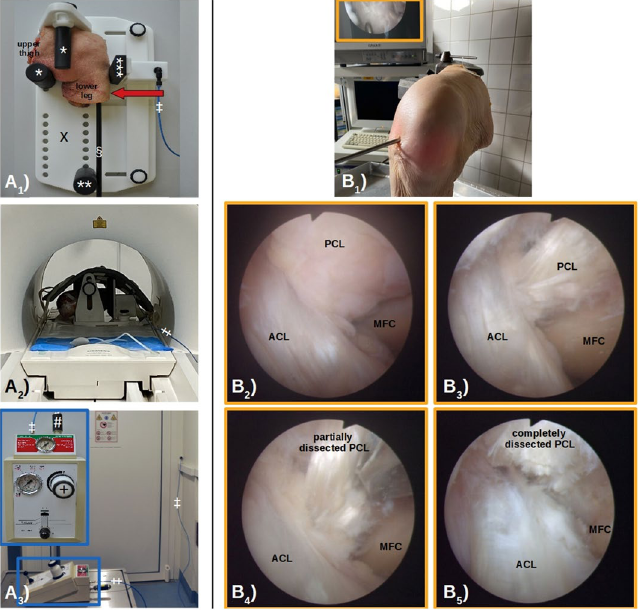
Figure 3. The MRI Posterior Drawer Test —Details of the MRI ( A ) and Arthroscopic Setup ( B ). ( A 1 ) Loading unit: The knee joint specimen was positioned on the base plate (X) in the lateral position at 90° of flexion and fixed with two counter-bearings at the distal upper thigh (*) and one counter-bearing at the distal lower thigh (**). Posterior loading of the tibia relative to the fixed femur (red block arrow) was induced via the padded pressure applicator (***) placed on the level of the tibial tuberosity. To compensate for the lacking distal lower thigh, a polyvinyl-chloride rod was inserted into the medullary cavity (§) to extend the tibia. The loading unit was connected to the control unit by standard pressure lines (‡). ( A 2 ) Fully operational setup: The specimen- loaded device was positioned centrally in the clinical MRI scanner’s bore and covered with an 18-channel body coil used for imaging. A pressure line connected the loading and control units (‡). ( A 3 ) Control unit: Outside of the scanner room, the control unit was connected to the loading device (‡). Once pressurized by carbon dioxide cartridges (#), pressure level (and resultant force on the joint) were controlled by a manometer ( +). Left upper box (framed in blue) indicates close-up view of the control unit. ( B 1 ) Arthroscopy setting: Following injection of fluid, the knee joint was accessed via the anterolateral portal. Arthroscopy tower in the background. ( B 2–5 ) Arthroscopic views of a right knee joint undergoing serial transections of the posterior cruciate ligament (PCL) in two separate arthroscopy sessions. Intact condition showing the PCL, the anterior cruciate ligament (ACL), and the medial femoral condyle (MFC) ( B 2 ). Following partial synovectomy of the PCL ( B 3 ), the PCL was partially transected during the first arthroscopy session by cutting approximately 50% of its cross-sectional area using arthroscopic scissors ( B 4 ). The functionality of the remaining PCL fibers was probed (not shown). During the second arthroscopy session, the PCL was completely transected ( B 5